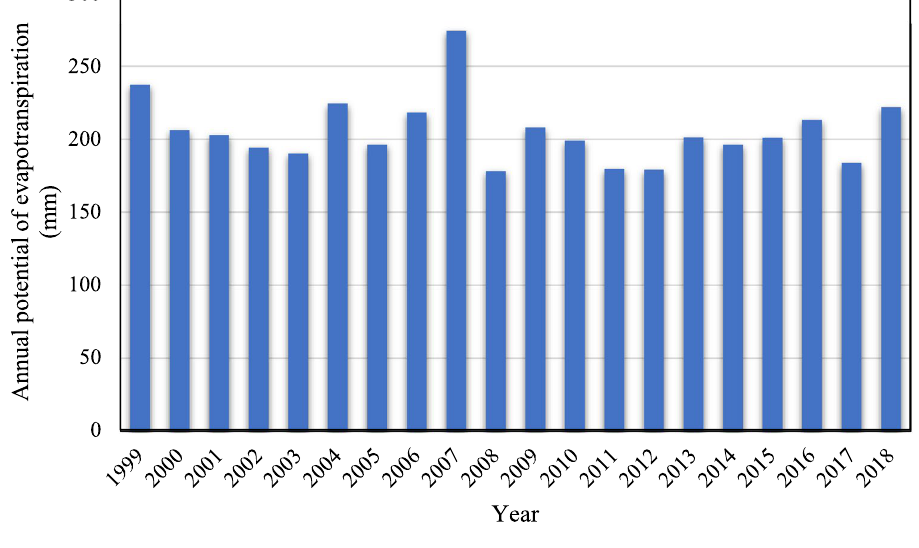
Fig. 9 Annual potential of evapotranspiration (mm) of Nari and Gaj formation